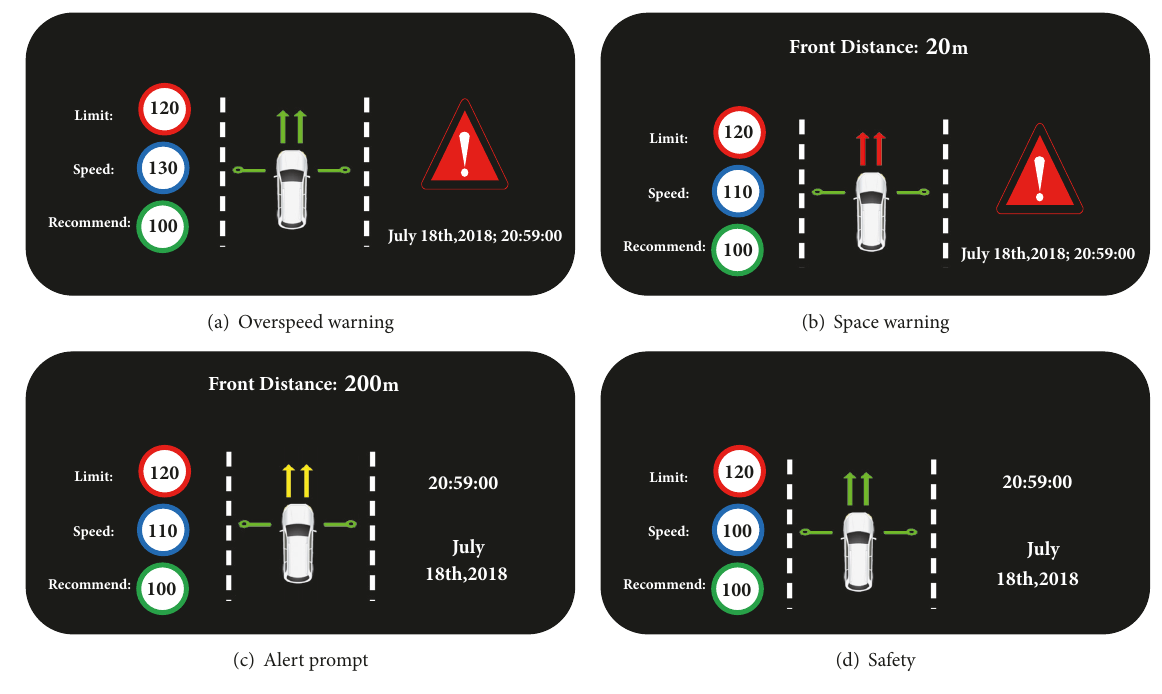
Figure 4: V2V software interaction